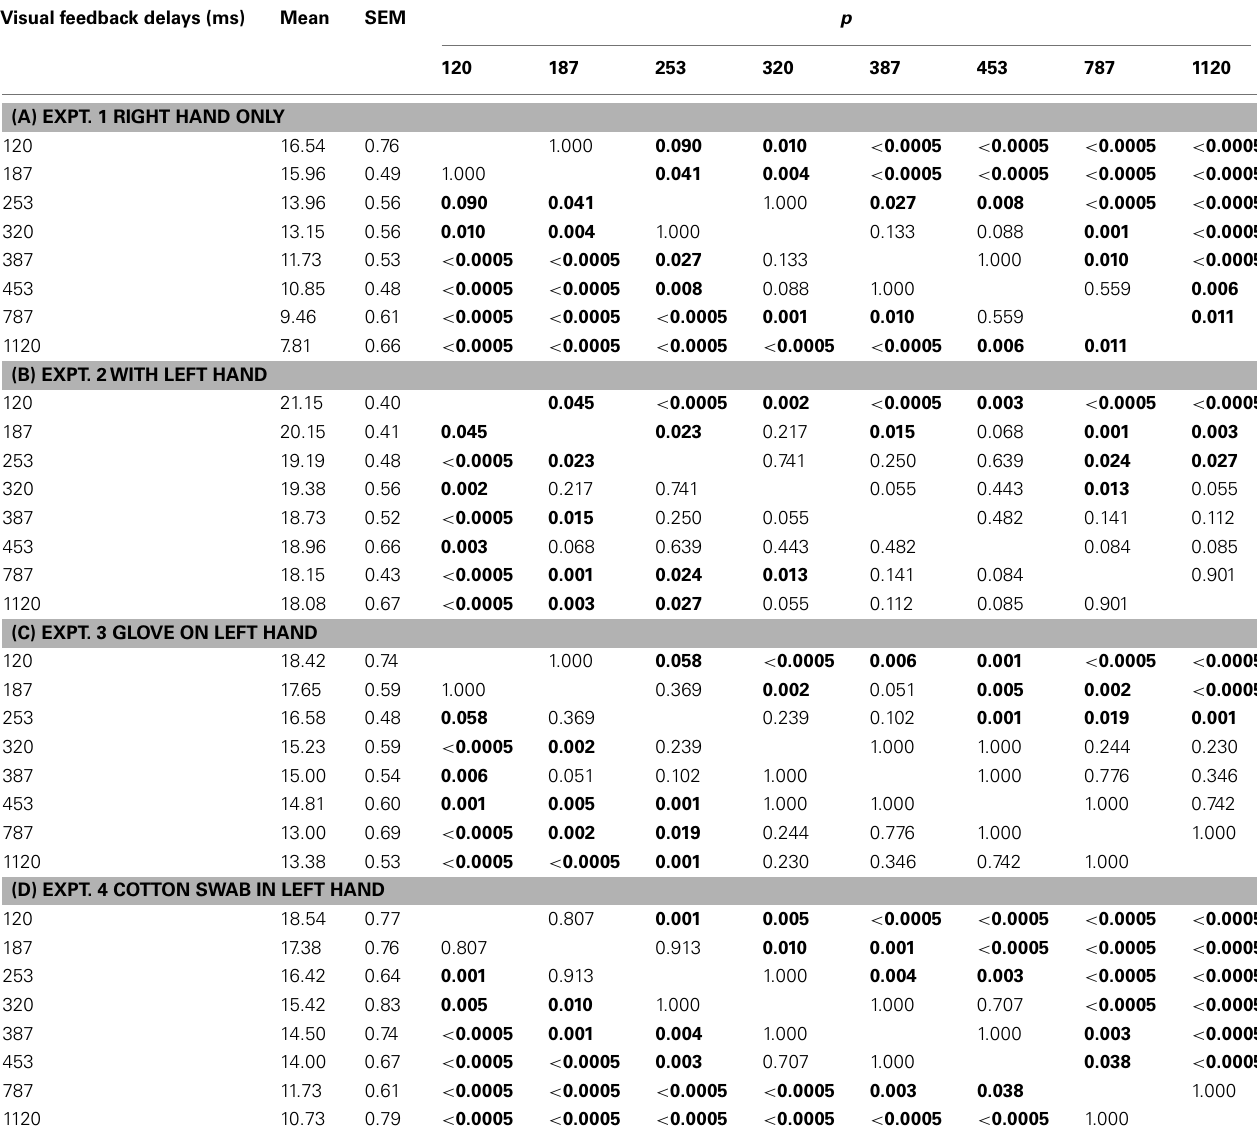
Table 2 | Results of post hoc multiple comparisons (Bonferroni) of the effects of visual feedback delays on pegboard test performance in experiments 1, 2, 3, and 4 ( N =